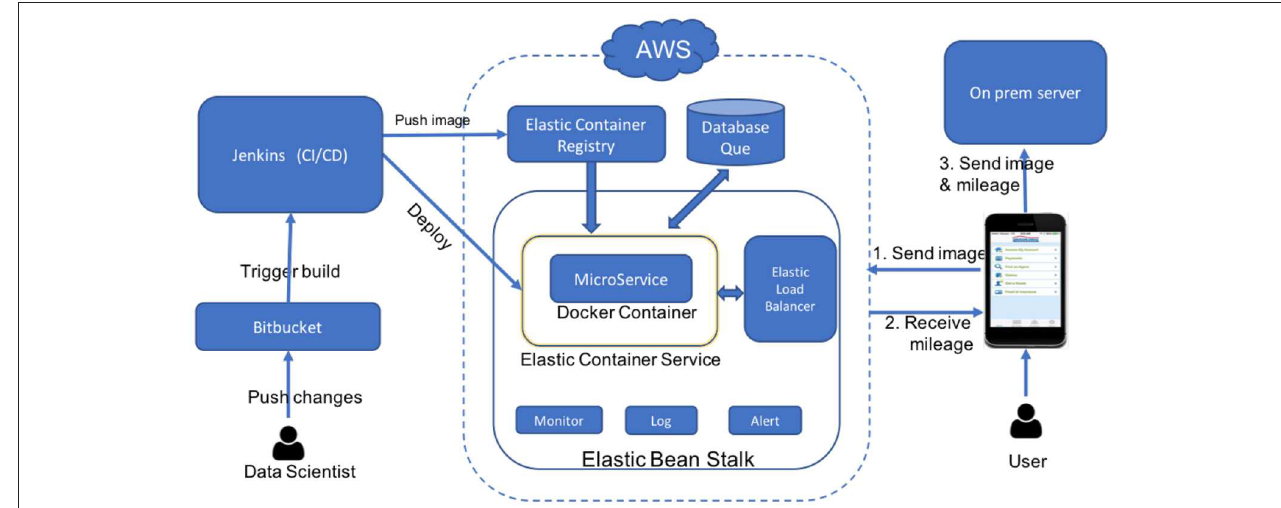
FIGURE 11 | Deployment